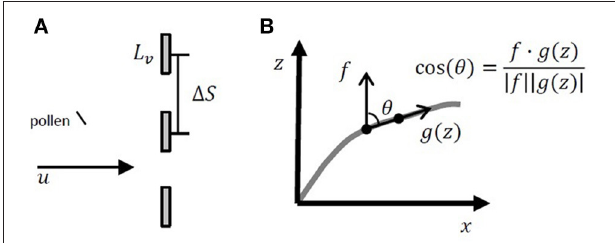
FIGURE 3 | (A) Diagram of pollen grain approaching three blades shown in cross-section. The blade width is L v and the center-to-center spacing between blades is 1 S . (B) Diagram of blade posture and determination of projected area in the x direction. The curved blade posture was broken into a series of linear segments, such that the blade position was converted to a series of vectors. The cosine of the angle between the blade orientation g ( z